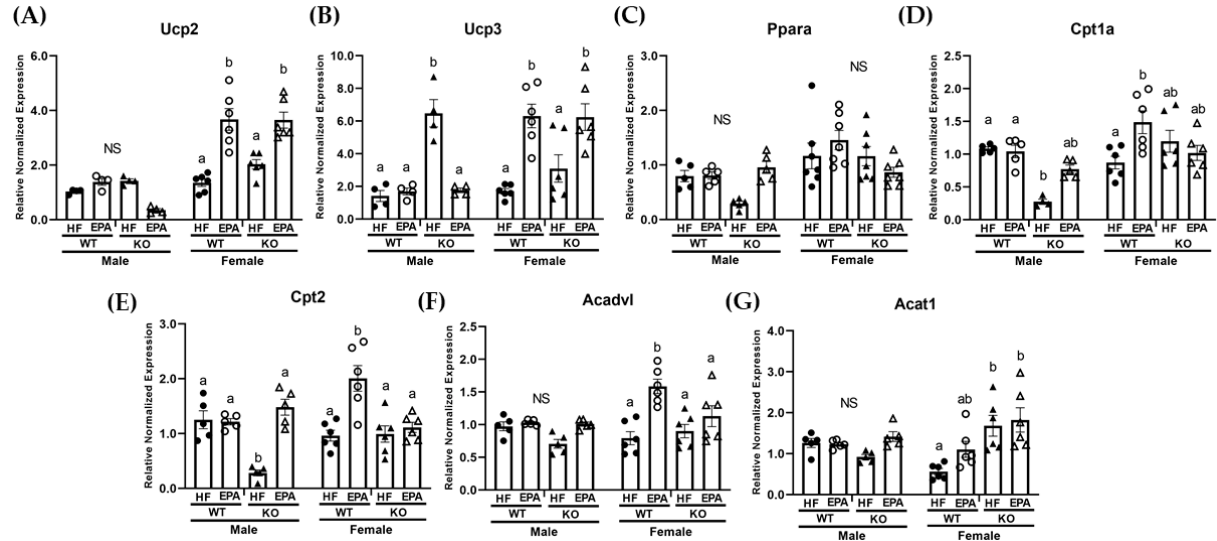
Figure 3. Sex-dependent effects on markers of hepatic lipid handling and fat oxidation. Gene expression of uncoupling proteins (Ucp) mRNA level of genes, ( A ) Ucp2 and ( B ) Ucp3 as well as genes related to lipid handling and mitochondrial oxidation, including ( C ) peroxisome proliferator-activated receptor-alpha ( Ppar- α ), ( D ) carnitine palmitoyltransferase ( Cpt ) 1a , ( E ) Cpt2 , ( F ) very long-chain specific acyl-CoA dehydrogenase ( Acadvl ), and ( G ) acetyl-CoA acetyltransferase ( Acat1 ) in male and female WT and UCP1 KO groups fed HF diets and EPA supplemented HF diets. ( A – G ) Data are expressed as mean ± SEM, n = 4–6; means without a common letter (a, b) differ in each male or female group; means with any common letter (a or b vs. ab) are not different from each other. NS indicates no significant post ‐ hoc comparisons.